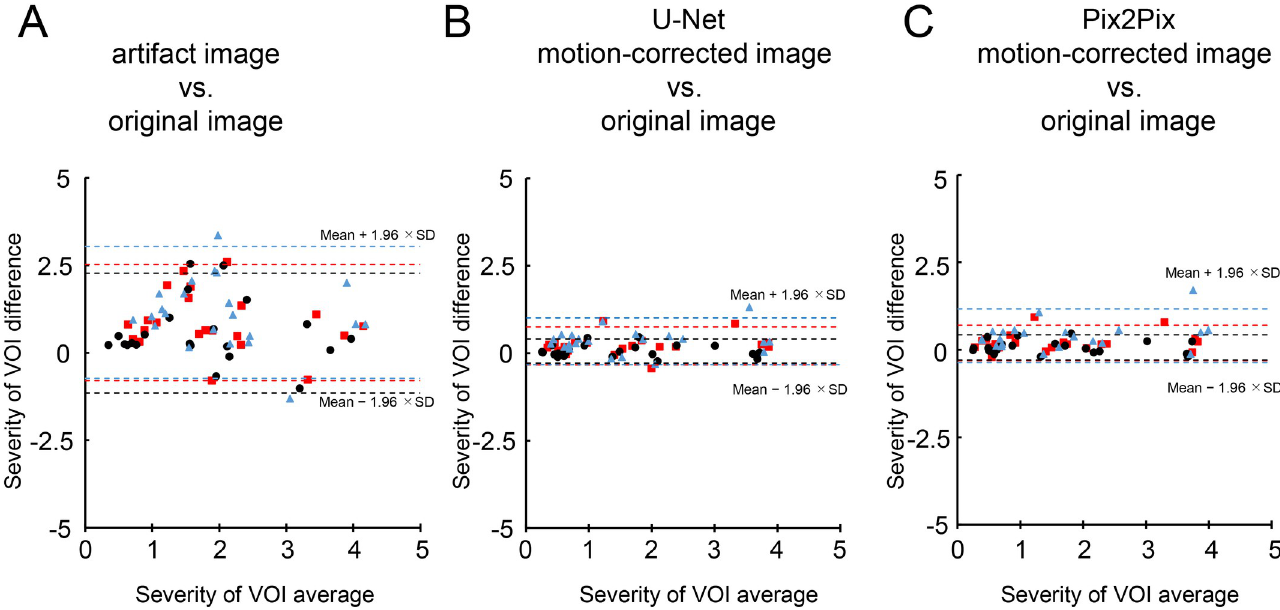
Fig 8. The Bland-Altman plot for VSRAD analysis results. Bland-Altman analysis results are shown for (A): severity of voxel of interest (VOI) atrophy of artifact vs . the original image, (B): severity of voxel of interest (VOI) atrophy of U-Net motion-corrected vs . the original image, (C): severity of voxel of interest (VOI) atrophy of Pix2Pix motion-corrected vs . the original image. The dotted line and white boxes plot show the relationship between the ± 1.96 standard deviation(SD) limit of agreement of the artifact image and the original image, and the dashed line show the relationship between the ± 1.96 SD limit of agreement of the motion-corrected image for U-Net or Pix2Pix and the original image. The rotation angle and k-space interval are plotted as black circles for 1˚_30 pixel, red squares for 2˚_20 pixel, and blue triangles for 3˚_10 pixel.